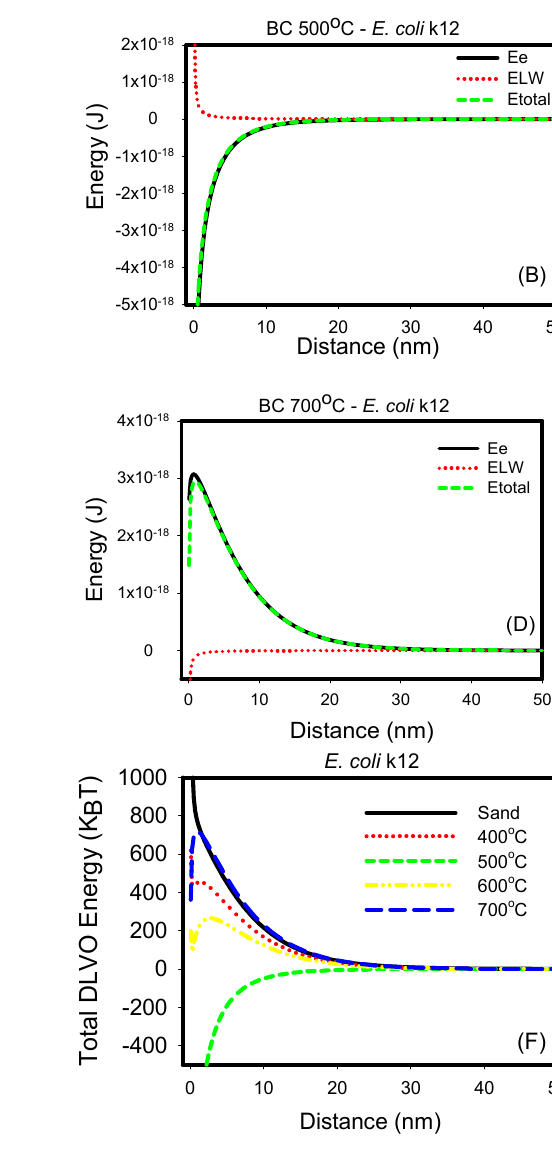
Figure 3. ( A – E ) Electrostatic, van der Waal and total energy profiles as a function of distance for interactions between E. coli k12 and biochars 400, 500, 600, and 700 °C and sand in DIW. ( F ) Comparison of all total energy profiles between E. coli k12 and all biochars and sand in water. The total energy profiles quantified between biochars and E. coli k12 were statistically different ( p < 0.001).